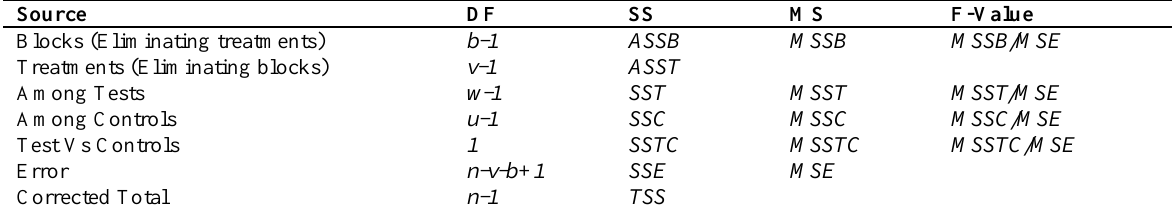
Table1. The ANOVA table for augmented